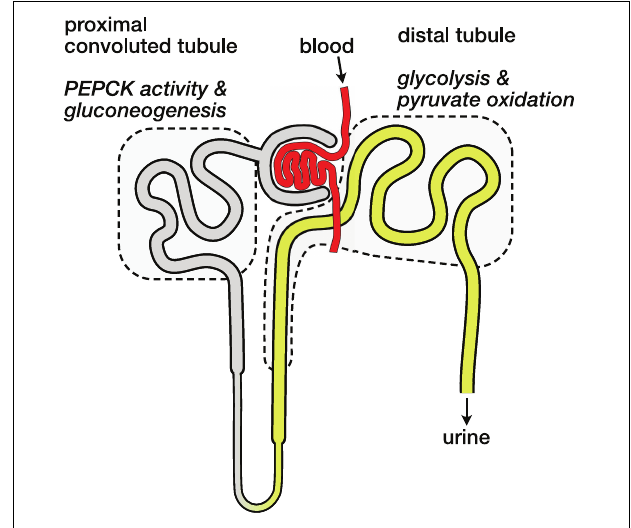
FIGURE 4 | Schematic diagram of nephron showing main compartments for gluconeogenesis and pyruvate oxidation. Blood carrying hyperpolarized [1- 13 C]pyruvate is filtered and pyruvate enters cells both via the tubular lumen (gray and yellow) and from the surrounding capillaries (not shown). The proximal convoluted tubule is the main site of renal gluconeogenesis. The distal tubule is the main site of renal glucose and lactate oxidation, and labeled bicarbonate resulting from PDH activity is attributed to this